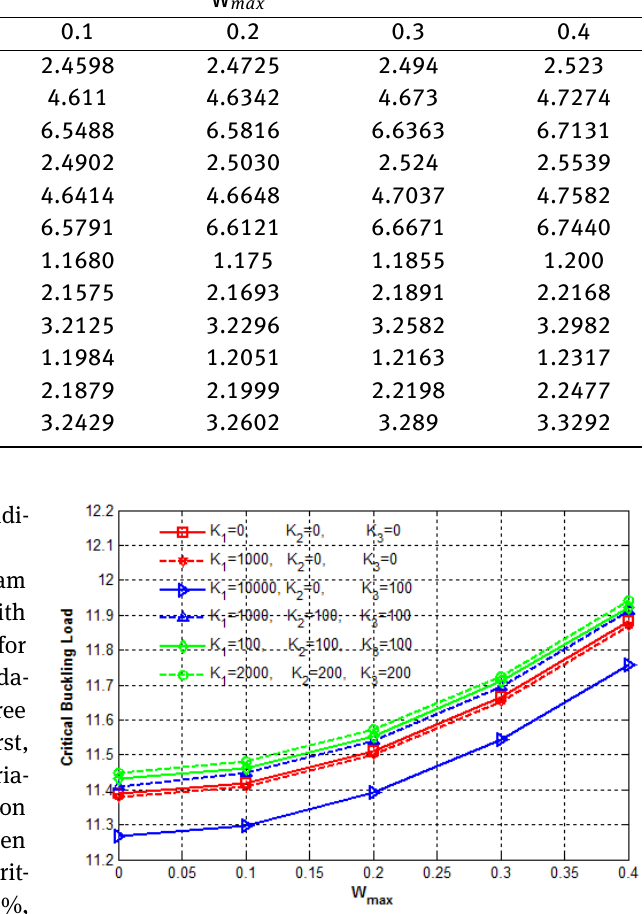
lingloadunderuniformlydistributedinplaneload N m x pect ratio of 15, and SS boundary condition with 0.25% of SWCNT volume fraction on SWCNTRLCB. There are two ob- servations comes out from the study. First, whenever foun- dation parameter doubled, the foundation supporting na- ture increases. Secondly, the effect of shear parameter K 2